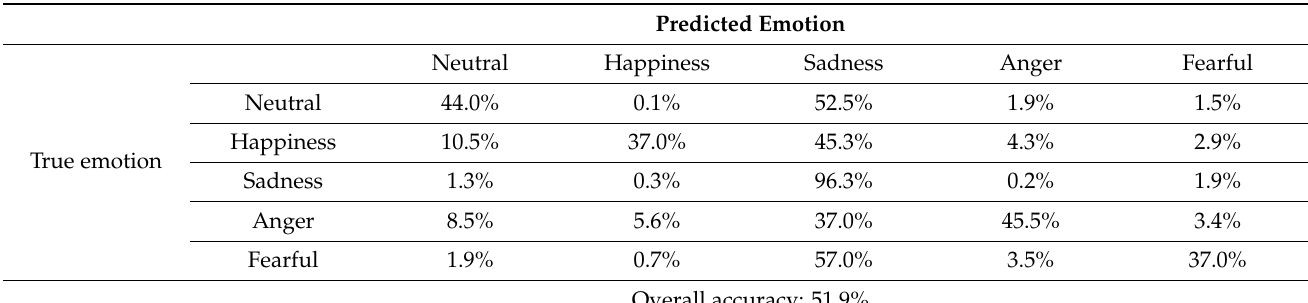
Table 4. Confusion matrix of the emotion classification results of the baseline CNN that was trained on the Korean CADKES mixed with the PSTATION